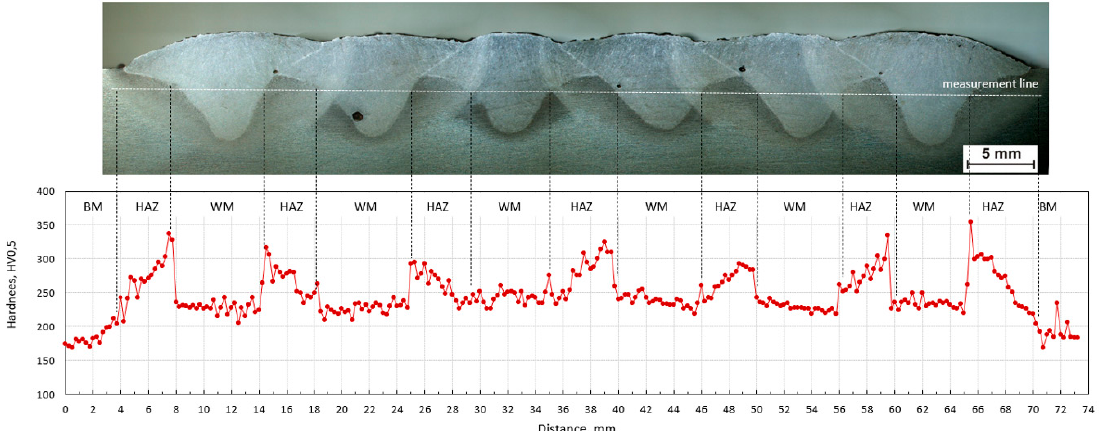
Figure 18. Hardness HV 0.5 distribution in plate B; BM—base material, WM—weld metal, HAZ—heat-affected zone.